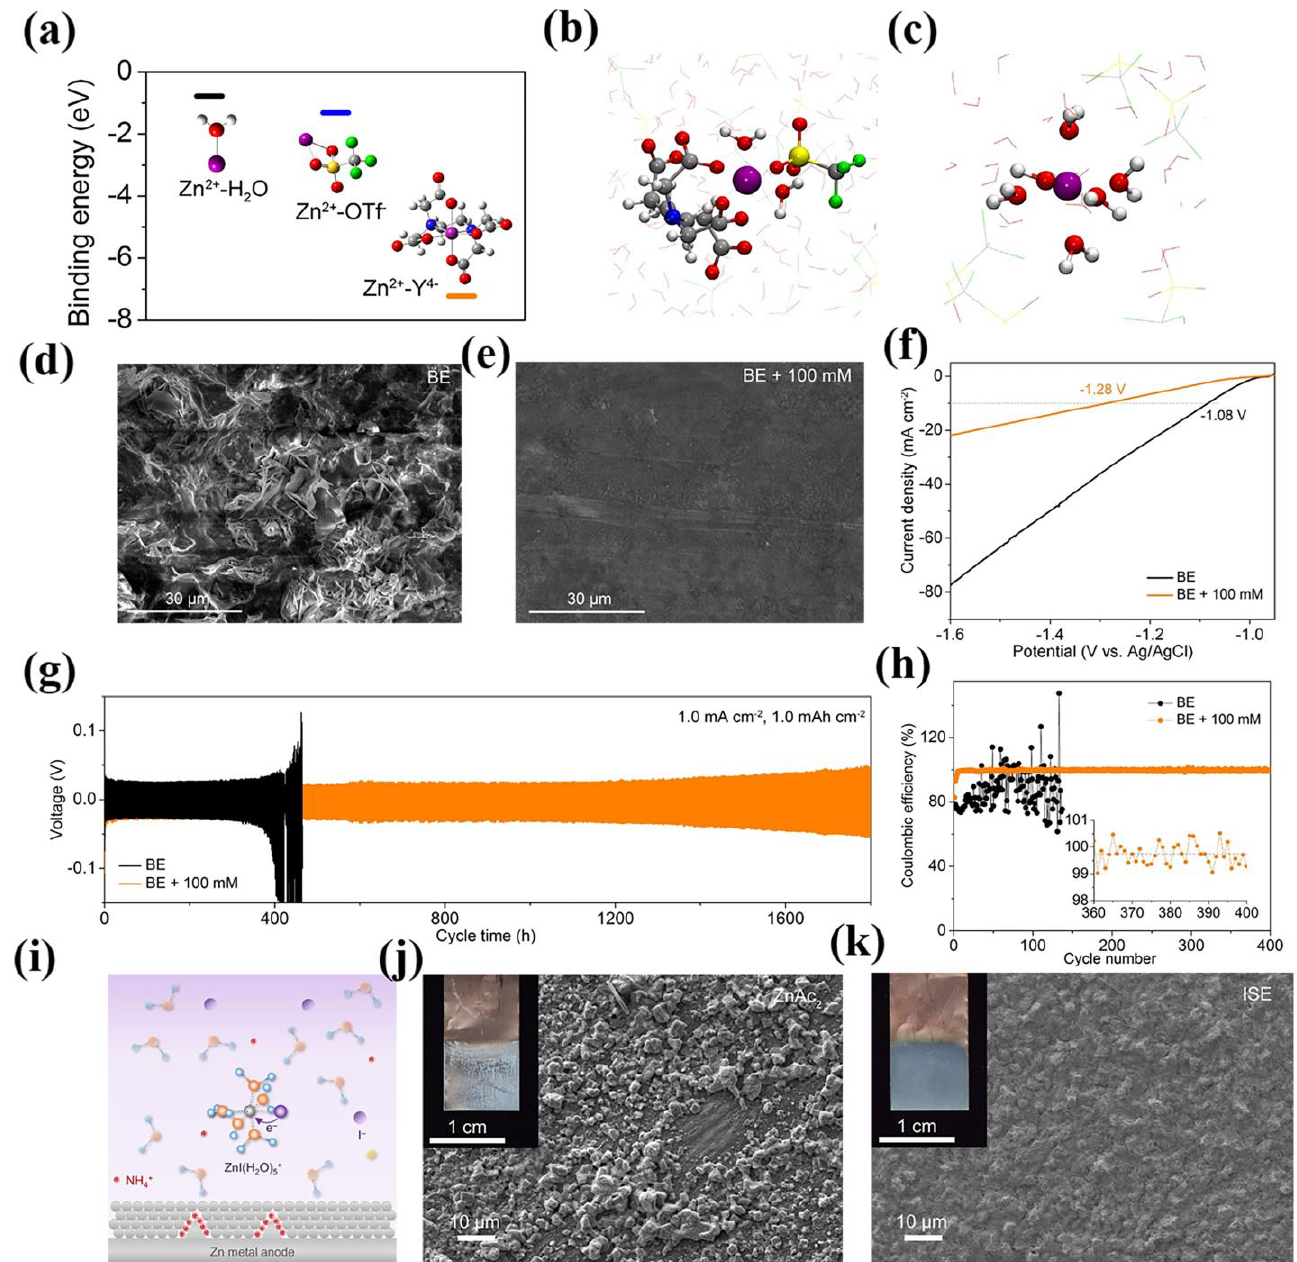
Figure 8. ( a ) The binding energy of Zn 2+ -H 2 O, Zn 2+ - OTf − , and Zn 2+ -Y 4- complexes. ( b ) Schematic of dual-anion electrolyte and ( c ) base-line electrolyte. ( d ) and ( e ) SEM images after 50 cycles in different electrolytes. ( f ) LSV of different electrolytes. ( g ) Galvanostatic cycling performances of symmetric Zn||Zn cells in different electrolytes at 1.0 mA cm − 2 with 1.0 mAh cm − 2 . Adapted with permission from Ref. [90]. Copyright 2022 Journals of Power Sources. ( h ) Coulombic efficiencies of Zn 2+ plating/stripping in asymmetric Zn||Cu cells with BE and BE + 100 mM at 1.0 mA cm − 2 with 1 mAh cm − 2 . ( i ) The NH 4+ electrostatic shielding layer inhibits the dendritic growth. SEM of Zn deposition in ( j ) 1 M ZnAc 2 and ( k ) ISE. Adapted with permission from Ref. [91]. Copyright 2022 American Chemical